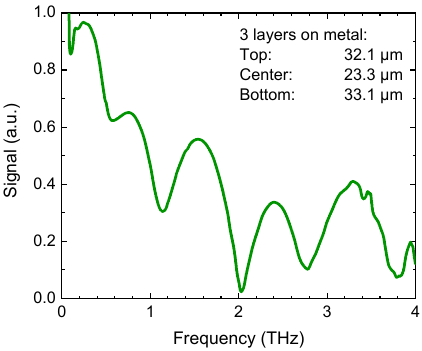
Figure 11. The frequency-domain representation of a THz pulse reflected from a three-layer coating on metal. Thicknesses of the individual layers are indicated. The layers give rise to interference signatures in the transfer function. Courtesy of Helmut Fischer GmbH.